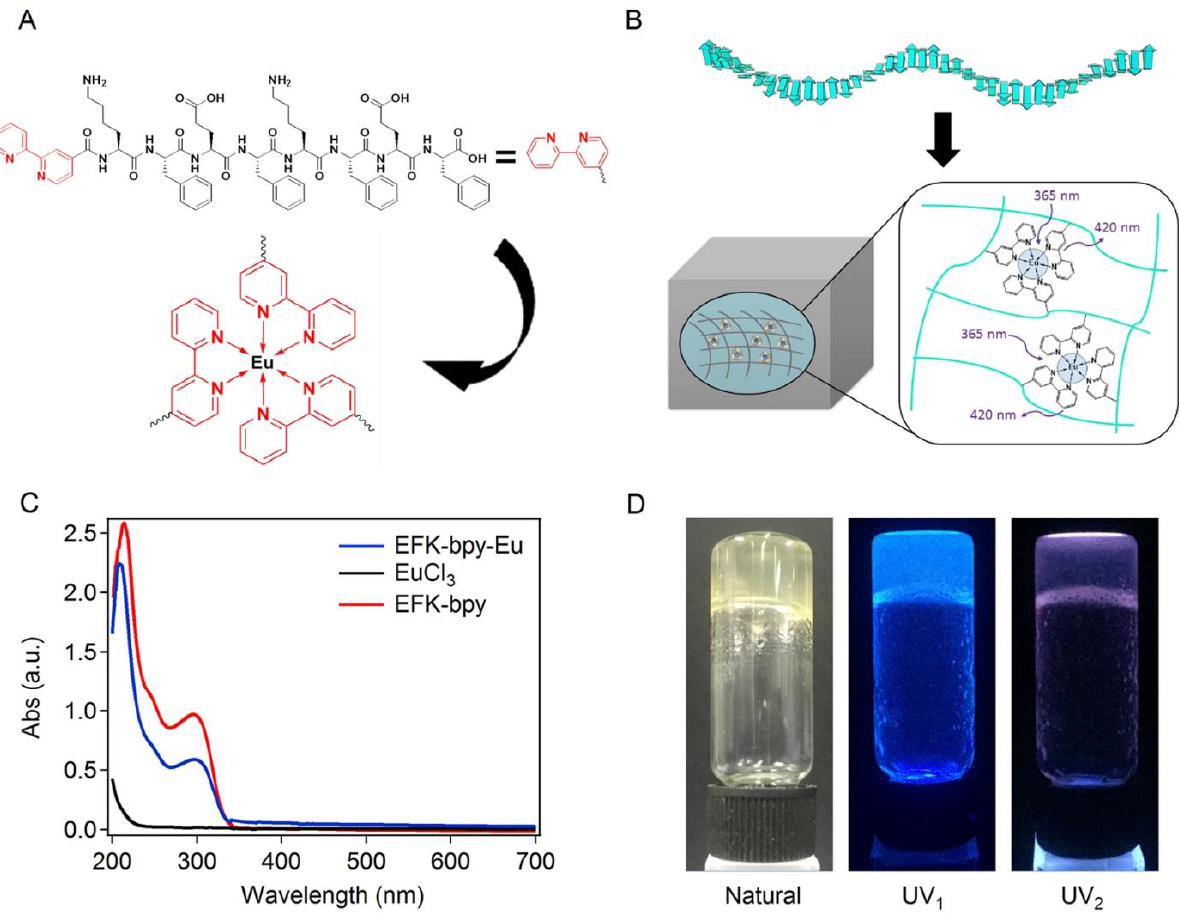
Figure 3. Coordination with Europium yields cross-linked luminescent hydrogels from a peptide with bipyridinyl moieties. ( A ) peptide structure with metal-binding bipyridinyl group in red. ( B ) schematic of peptide self-assembly into stacks and cross-linking with the metal. ( C ) UV-visible absorbance spectra of the cross-linked peptide gel (EFK-bpy-Eu), and the metal (EuCl 3 ) or peptide (EAK-bpy) components alone. ( D ) photographs of the luminescent gels under natural and UV light. Reproduced from [9] under a Creative Commons license.